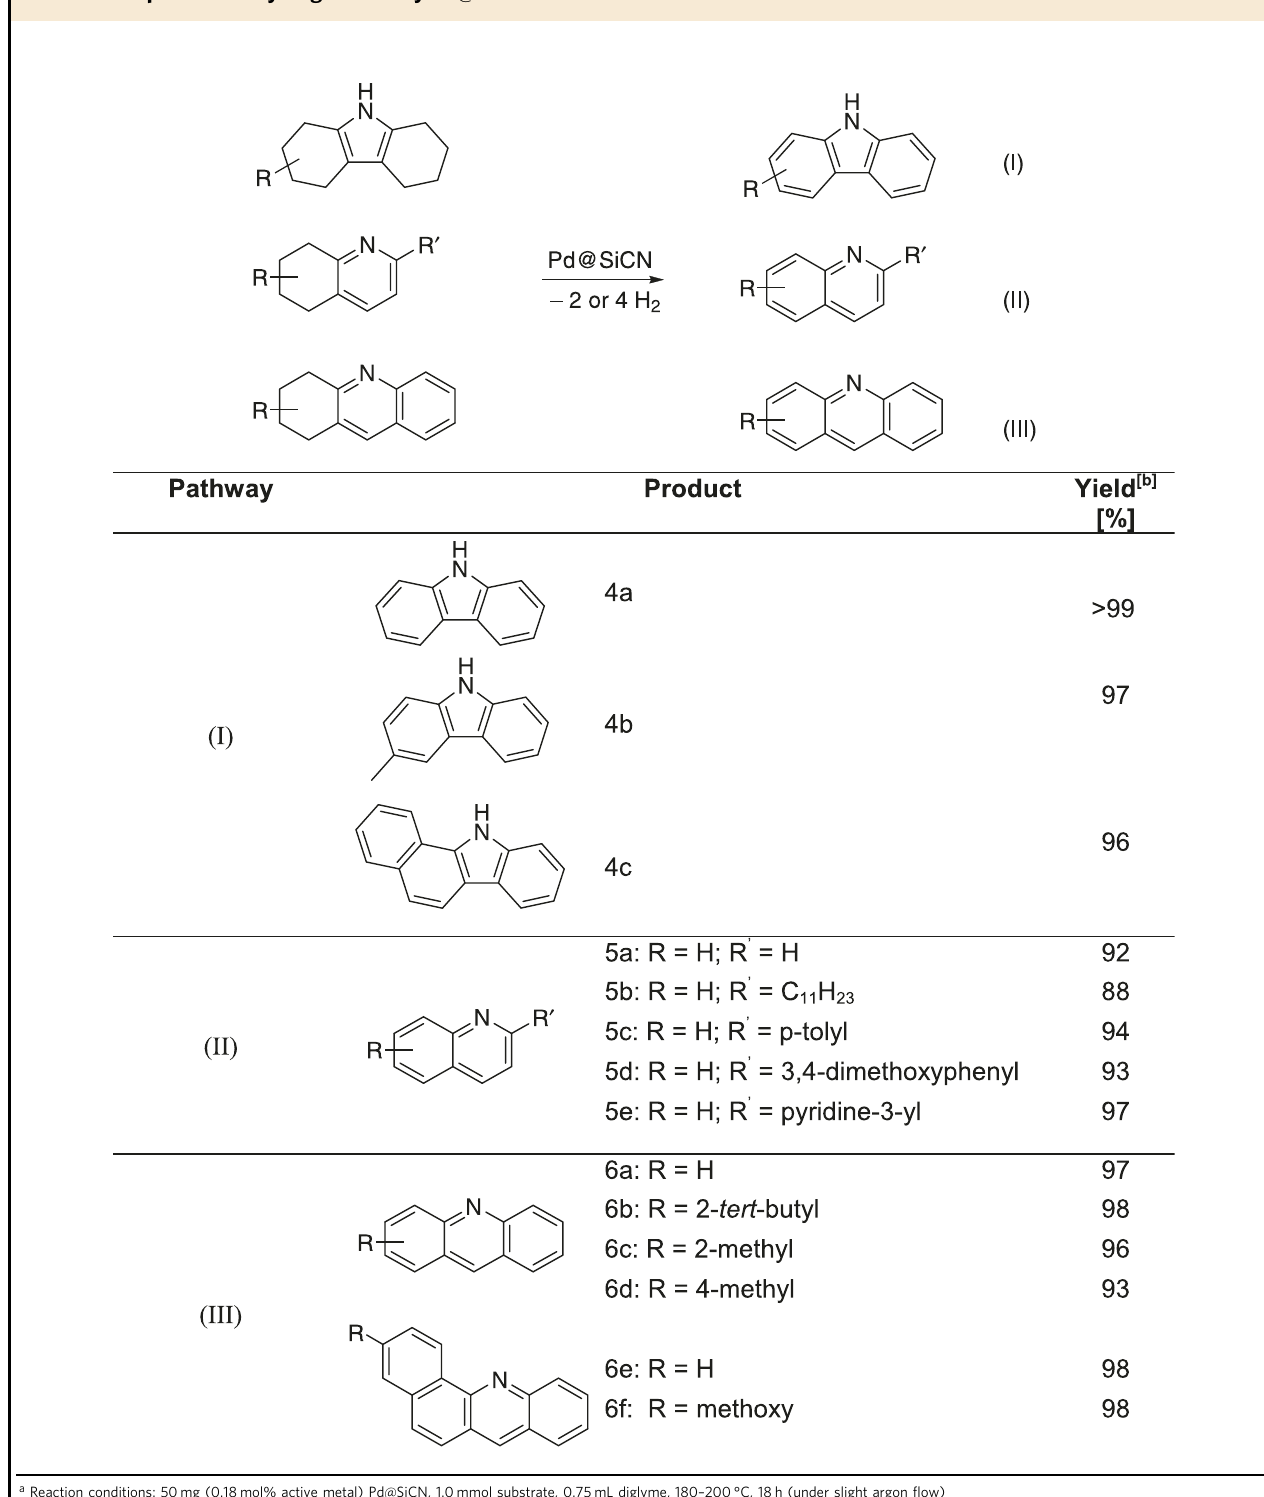
Table 3 Acceptorless dehydrogenation by Pd@SiCN